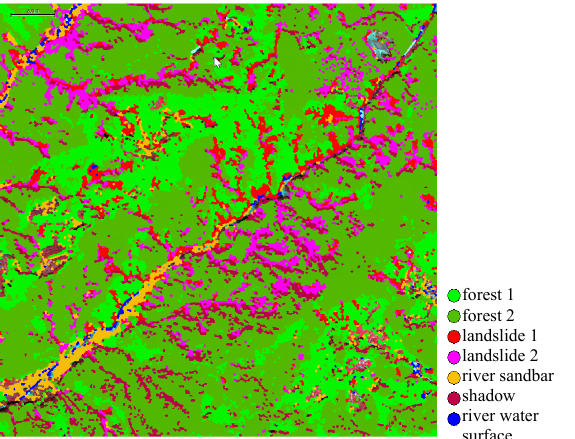
Figure 8. The result of classification by NN method (segmentation method: SLICO, region size: